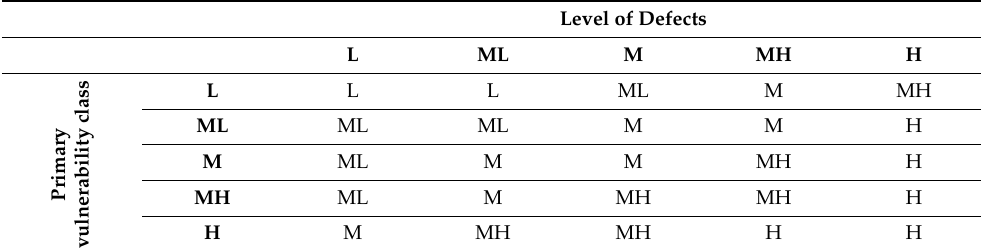
Table 3. Combination of the primary vulnerability class with the level of defects.